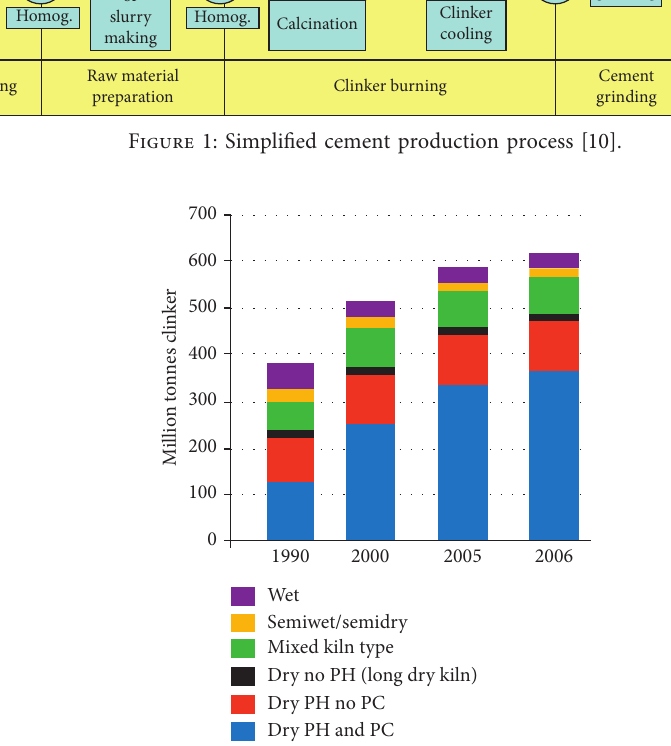
Figure 2: Global clinker production per kiln type according to the GNR database [12].